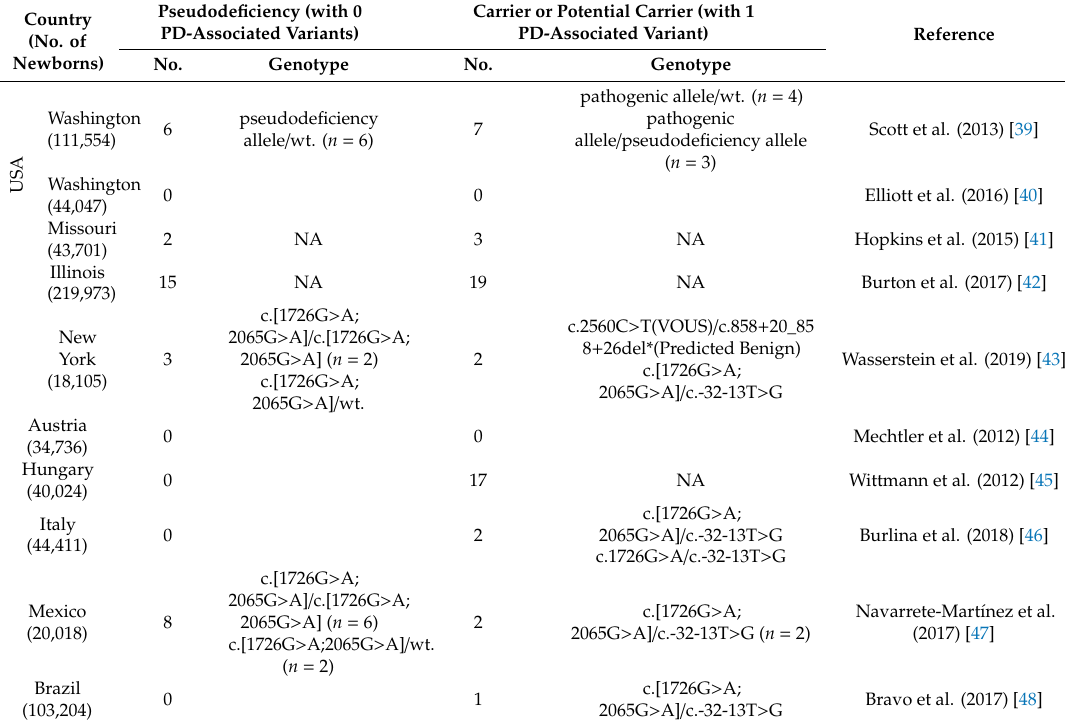
Table 3. Number of pseudodeficiencies and carriers in each